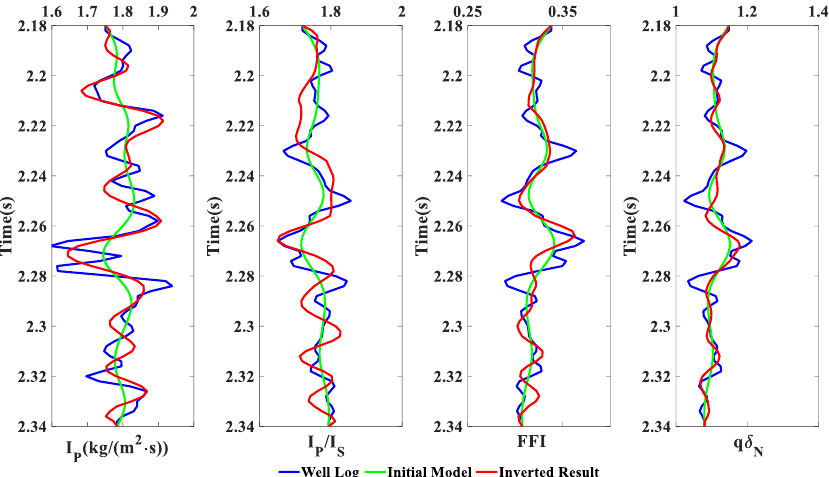
Figure 10. Comparison between the estimated model parameters and well logs at the well loca- tion .